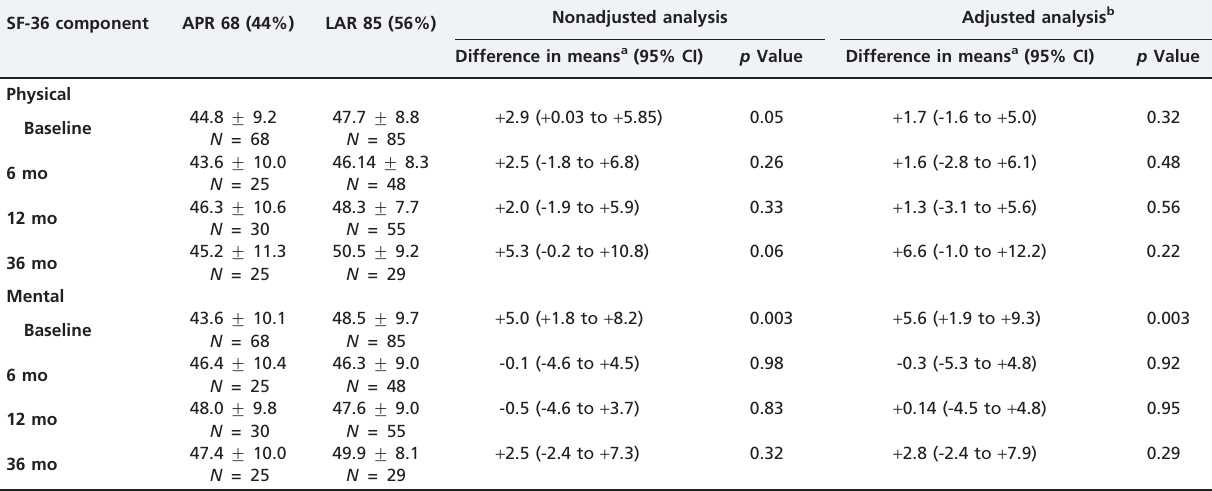
Table 4 - Overall quality of life.